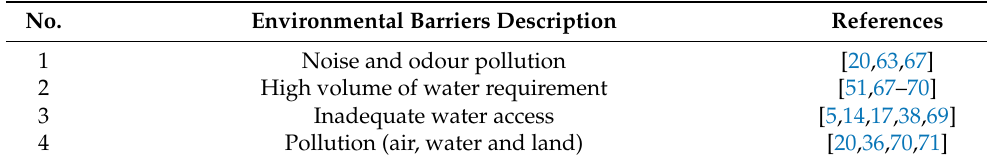
Table 4. Indonesian biogas development: environmental